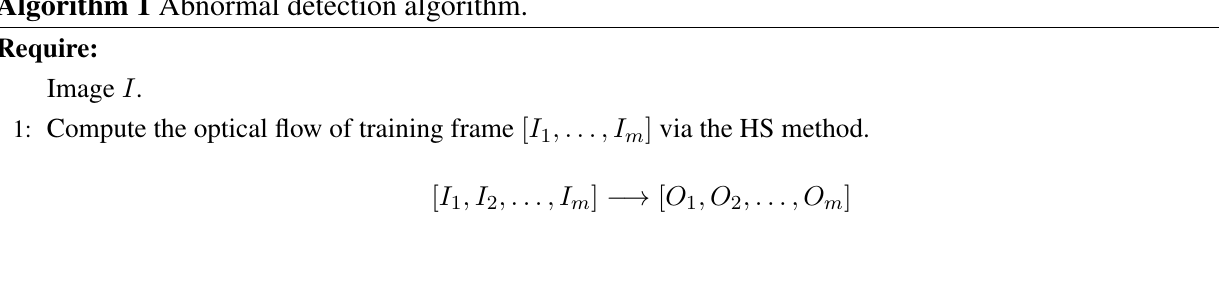
Algorithm 1 Abnormal detection